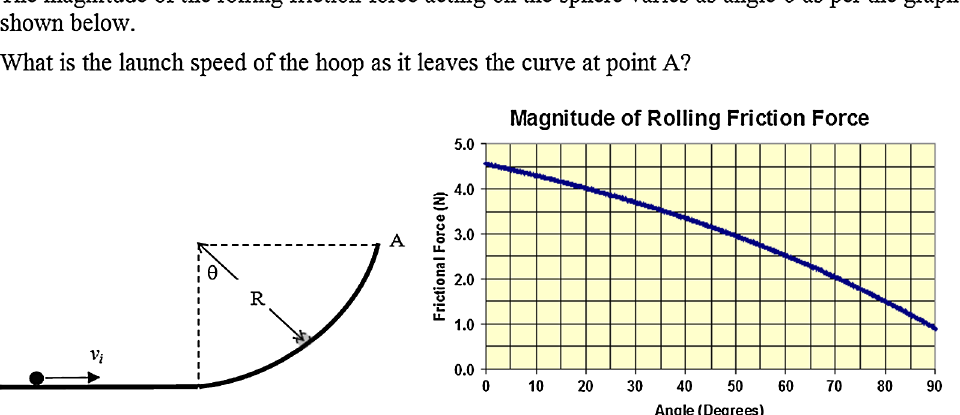
FIG. 3 (color online). The sphere problem (interview